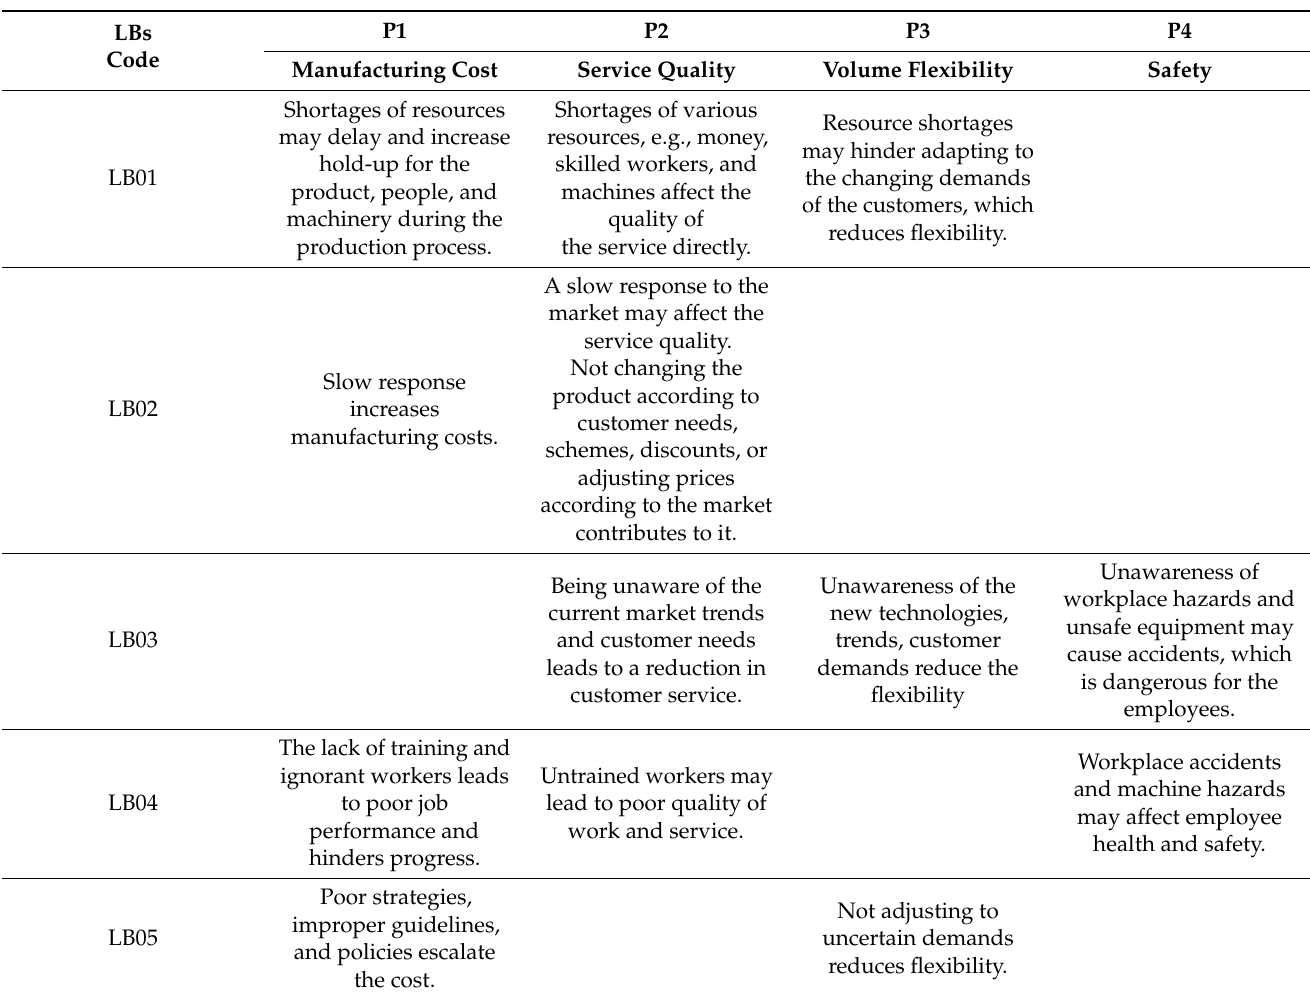
Table 8. Interpretive